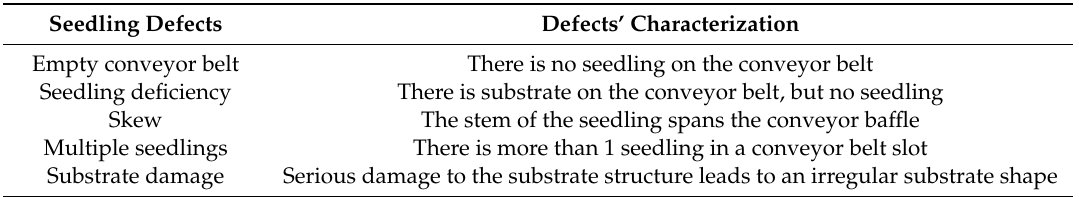
Figure 9. Cabbage seedling defects. Table 1. Seedling defect